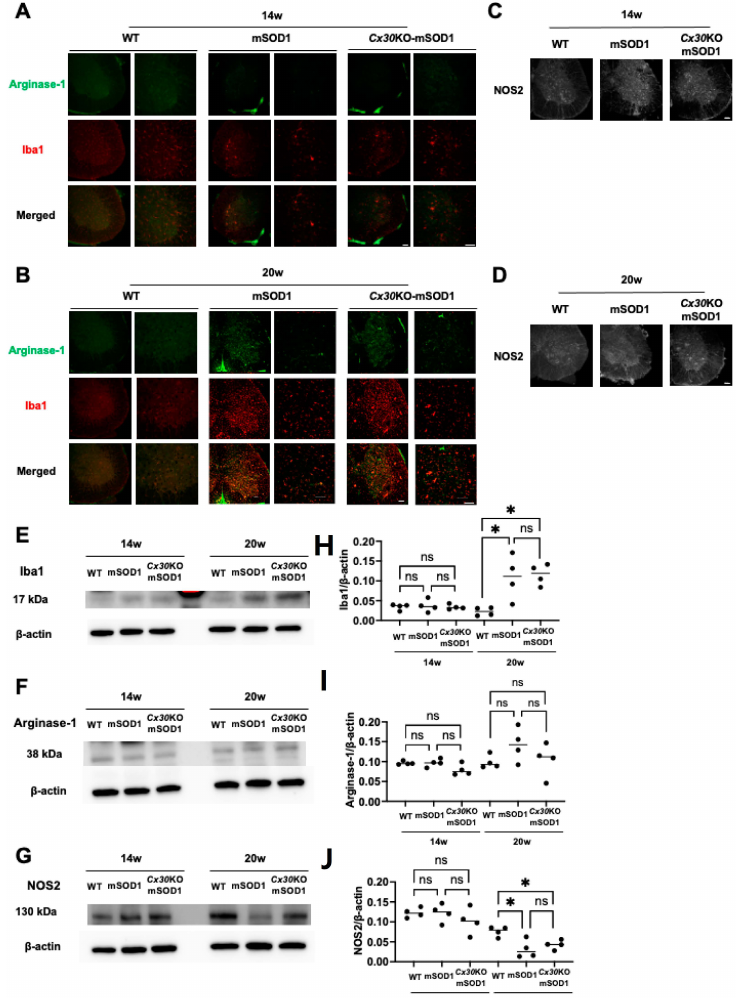
Figure 6. Immunohistochemical and Western blot analysis of microglial activation in the lumbar spinal cords of ALS model mice at different weeks of age. ( A , B ) Representative images of immunos- taining for Iba1 and Arg1 in the lumbar spinal cords of WT, mSOD1, and Cx30 KO-mSOD1 mice at 14 and 20 weeks. ( C , D ) Representative image of immunostaining for NOS2 in the lumbar spinal cords of WT, mSOD1, and Cx30 KO-mSOD1 mice at 14 and 20 weeks. ( E – J ) Representative Western blot images and analysis of Iba1, Arg1, and NOS2 protein levels normalized to β -actin at 14 and 20 weeks. n = 4. Scale bars: 100 µ m. Statistical differences were evaluated using one-way ANOVA plus Tukey’s multiple comparison test. ns = not significant. * p <